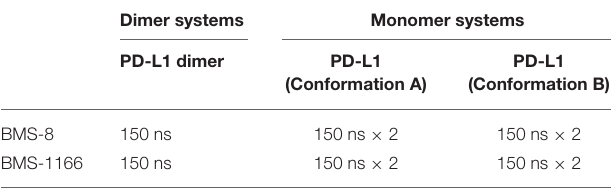
TABLE 1 | The details of conventional molecular dynamics simulations.